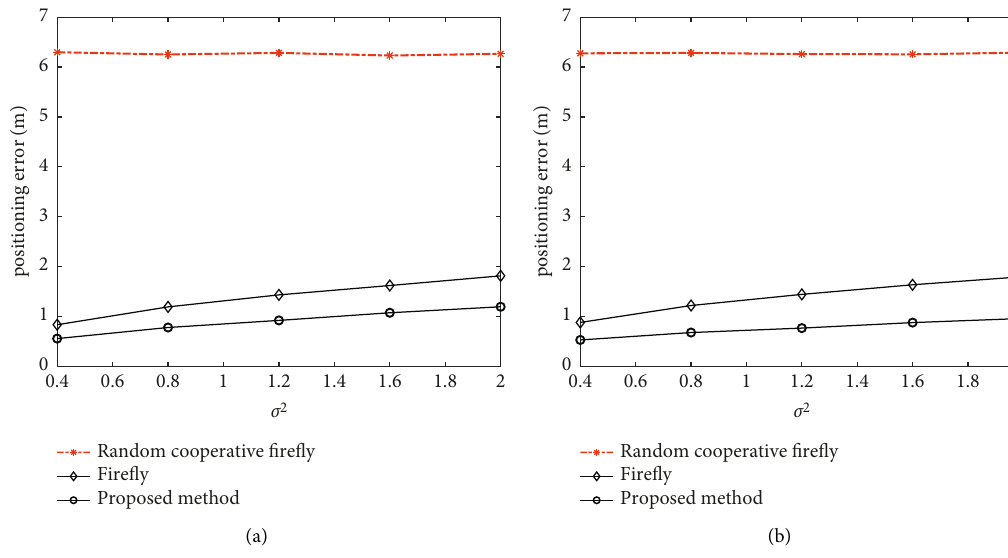
Figure 3: The effect of initial value on positioning accuracy. (a) I � 8, K � 4; (b) I � 16, K � 4.